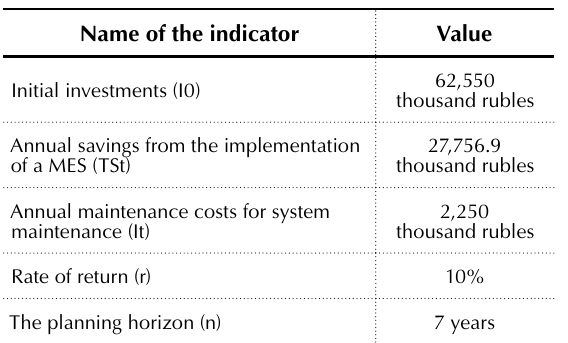
Table 4. Initial data for calculation of NPV of